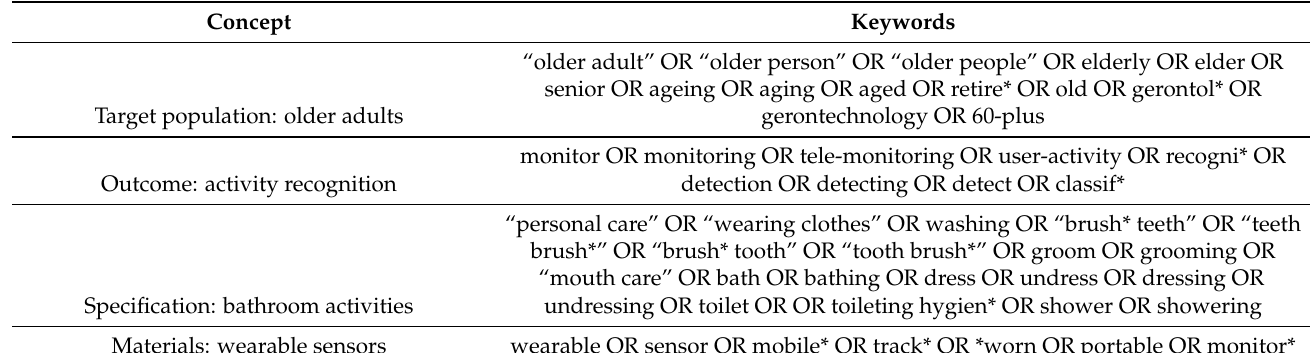
Table 1. Selected keywords for search. An asterisk (*) was used as a wildcard to broaden the search for words starting or ending with a